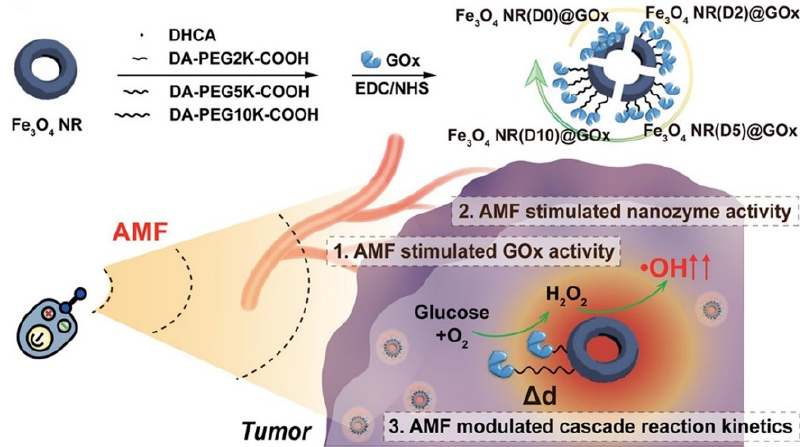
Figure 10. Fe 3 O 4 NR@GOx nanocatalysts used for tumor therapy under AMF. The top shows the assembly process of Fe 3 O 4 NR@GOx nanocatalysts, and the bottom shows their effect on tumor therapy. Reprinted with permission from Zhang et al., American Chemical Society [144].